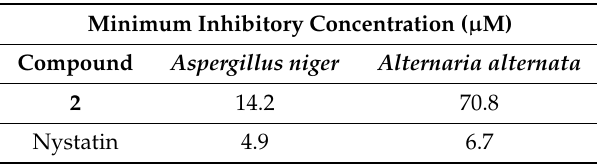
Table 6. MIC value of compound 2 with respect to the standard (Antifungal